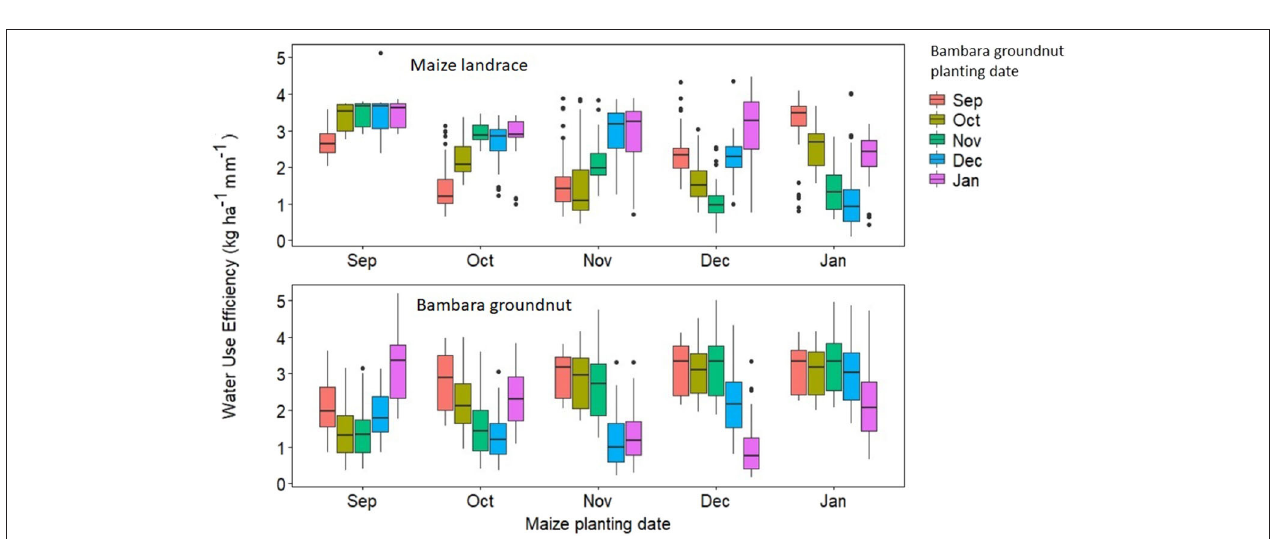
FIGURE 11 | Calculated water use efficiency (kg ha − 1 mm − 1 ) for maize and bambara groundnut across different planting date combinations under rainfed conditions obtained from six GCMs (ACC, CSS, CNR, GFD, NOR, and MPI). The x-axis represents the maize landrace planting dates and the colored boxplots represent the planting date for bambara groundnut. The effect of the interaction between maize landrace planting date and bambara groundnut planting date on maize landrace WUE - F -statistic: 38.93 on 24 and 875 DF, P = 0.000 and The effect of the interaction between maize landrace planting date and bambara groundnut planting date on maize landrace WUE - F -statistic: 35.16 on 24 and 875 DF, P =